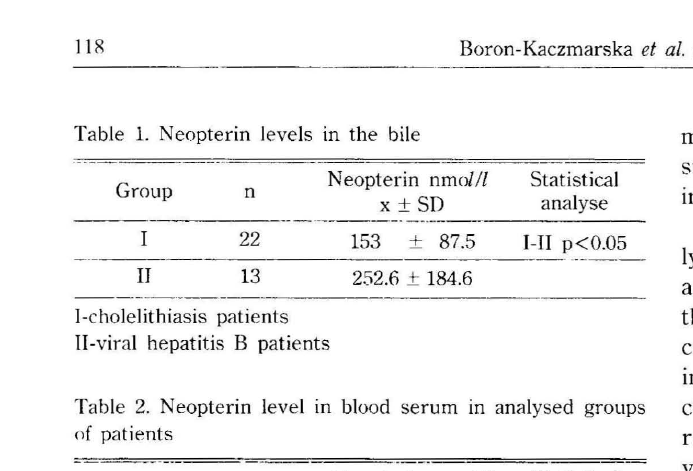
I-cholelithiasis patients II-viral hepatitis B patients Table 2. Neopterin level in blood serum in analysed groups of patients